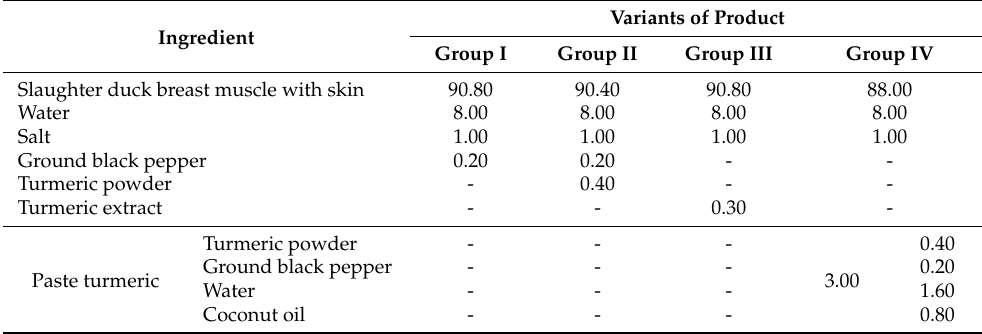
Table 1. Raw material composition of model duck meat burgers (% by weight in relation to the total amount of raw